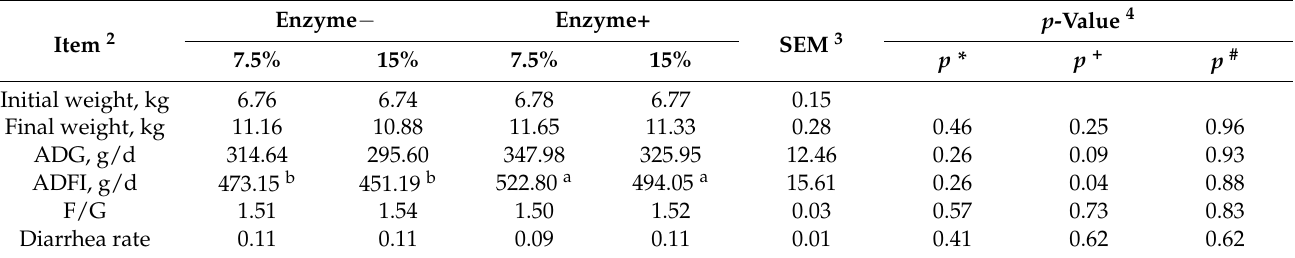
Table 4. Effects of different moisture contents (adding 7.5 vs. 15% water) and enzyme additions (adding 4 kg/t α -amylase or not) to extruded corn on the growth performance and diarrhea rate in weaning piglets 1 .